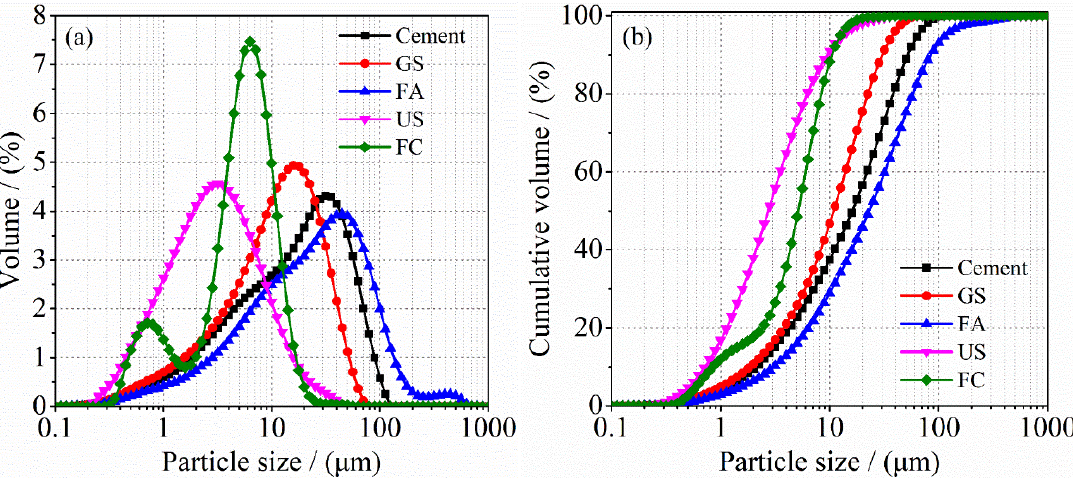
Figure 2. Particle size distributions of other cementitious materials: ( a ) differential curve, ( b ) cumulative curve.